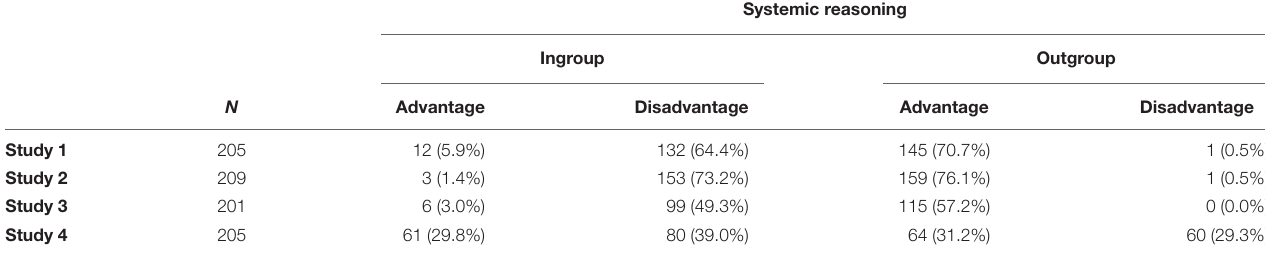
TABLE 4 | Systemic reasoning.